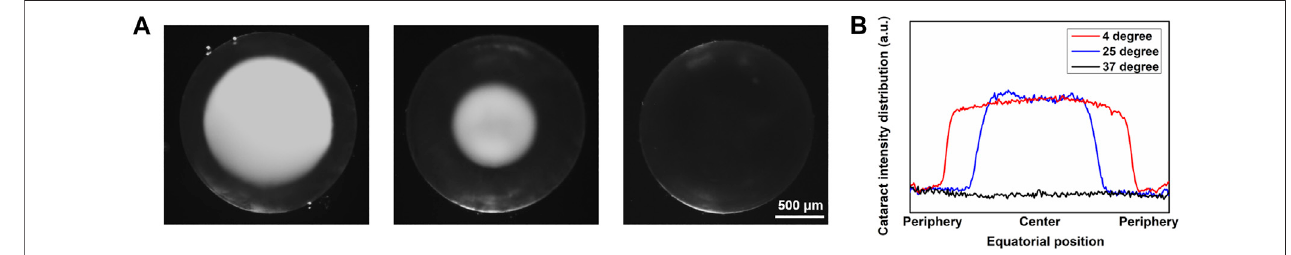
FIGURE 2 | Microscopic image of lens at different temperatures with cold cataract formation. (A) Anterior-view images of lens under dissecting microscope. From left to right, lenses were at 4 ° C, 25 ° C, and 37 ° C. Scale bar: 500 μ m. (B) Plot pro fi le of the equatorial line of the lenses at 4 ° C, 25 ° C, and 37 ° C.